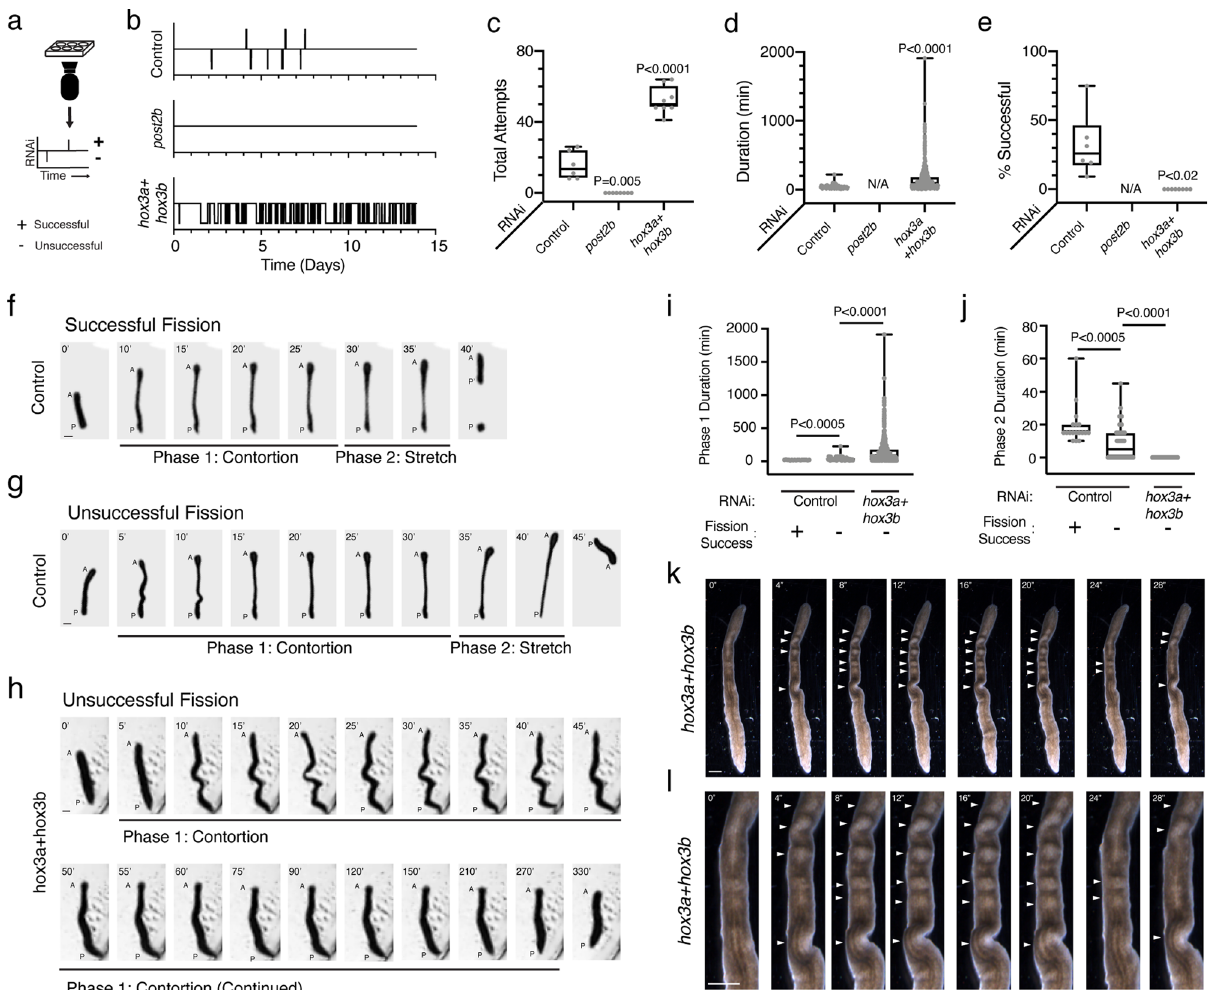
Fig. 3 post2b and hox3 are opposing regulators of asexual reproductive behavior. a Diagram of webcam time-lapse imaging and timeline visualization depicting successful (upward displacement) and unsuccessful (downward displacement) fi ssion attempts. b Representative activity timelines of fi ssion behavior from live imaging of control, post2b , and hox3a + hox3b RNAi animals. c – e Plots of ( c ) total number of fi ssion attempts (Control vs. post2b and hox3a + hox3b p -values = 0.005 and <0.0001, respectively), ( d ) duration of each attempt (Control vs. hox3a + hox3b , p -value < 0.0001), and ( e ) percentage of successful attempts for RNAi-treated animals (Control vs. hox3a + hox3b p -value = 0.194). n = 8, 6, and 6 animals for Control, post2b , and hox3a + hox3b RNAi samples, two independent repeats. Source data are provided as a Source Data fi le. f – h Representative images (5 min per frame, A = anterior, P = pre- fi ssion posterior, and P ’ = post- fi ssion posterior) of ( f ) successful and ( g , h ) unsuccessful fi ssion attempts divided into Phase 1 (Contortion) and Phase 2 (Stretch) for ( f , g ) control and ( h ) hox3a + hox3b RNAi-treated animals (experiment independently repeated once). i , j Plots of the duration of ( i ) Phase and ( j ) Phase 2 within each fi ssion attempt for RNAi-treated animals ( n = 18, 50, and 476 fi ssion events for Ctl Successful, Ctl Unsuccessful, and hox3a + hox3b Unsuccessful, respectively; Ctl Successful vs. Ctl Unsuccessful p -value = 0.0005; Ctl Unsuccessful vs. hox3a + hox3b Unsuccessful p -value < 0.0001). Source data are provided as a Source Data fi le. k , l Representative images of the ( k ) entire body or the ( l )